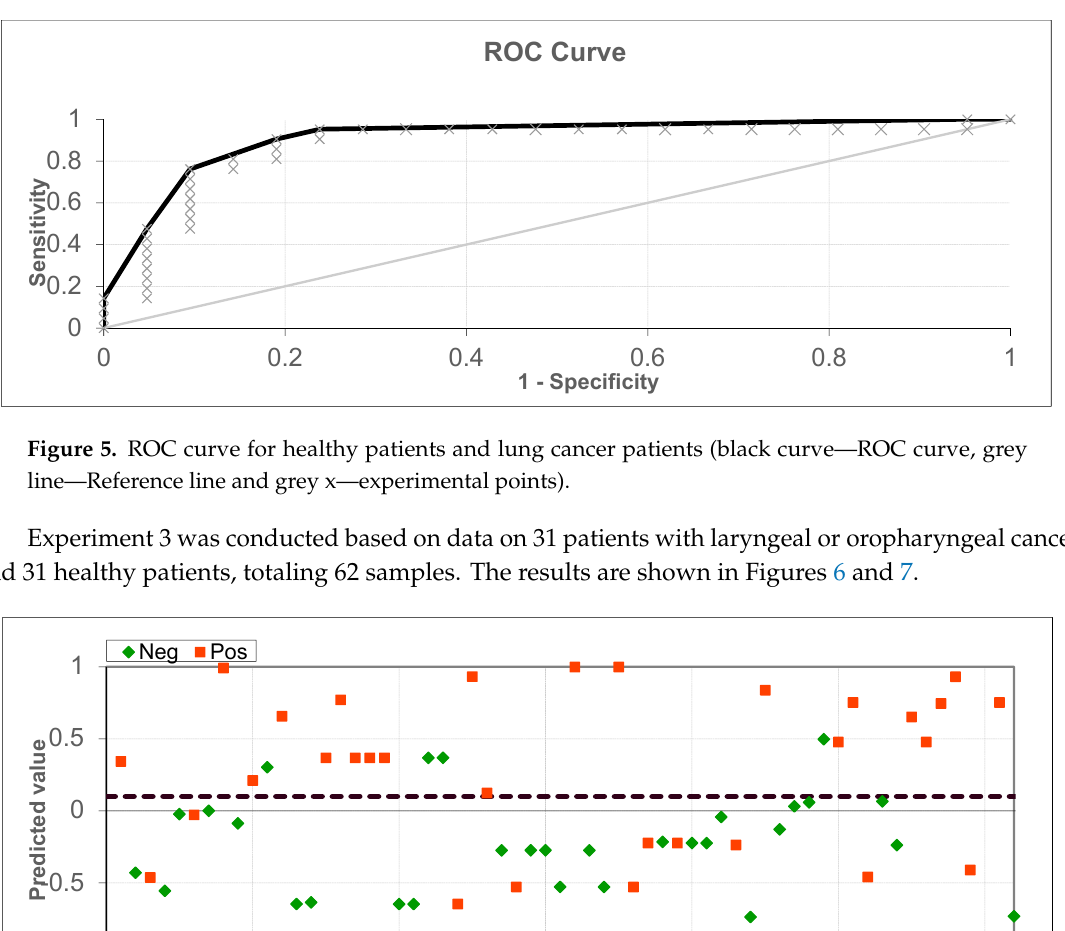
Figure 4. Scatter plot for healthy patients and lung cancer patients.